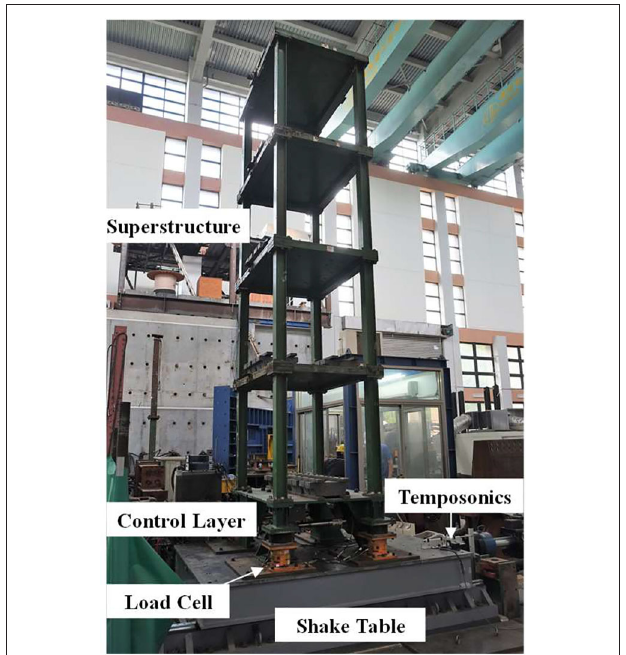
FIGURE 5 | Experimental setup of the experimental substructure of the 8-story BMD system.